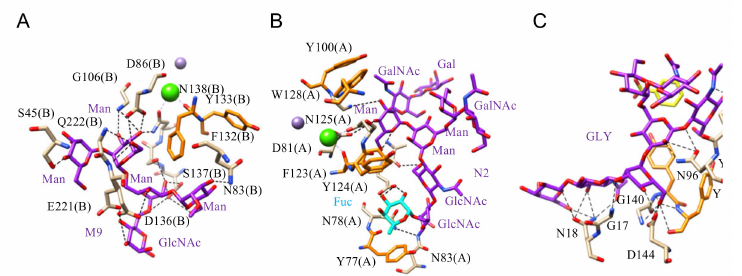
Figure 5. ( A ). Network of hydrogen bonds (black dashed lines) anchoring Man9 (M9) to PAL, the Pterocarpus angolensis lectin (PDB code 2PHN). Aromatic residues F132 and Y133 participating in stacking interactions with the pyranose rings of the oligomannoside are colored orange. ( B ). Network of hydrogen bonds (black dashed lines) anchoring N2 oligosaccharide to LoLII, isolectin II from Lathyrus ochrus (PDB code 1LGB). Aromatic residues Y77, Y100, F123, Y124, and W128 involved in stacking interactions with the pyranose rings of the oligosaccharide, are colored orange. The α 1,6-linked fucose (Fuc) participates in the H-bond network. ( C ). Network of hydrogen bonds (black dashed lines) anchoring a biantennary glycan (GLY) to Calsepa from Calystegia sepium (PDB code 5XFI). Aromatic residue Y141 and Y142 participating in stacking interaction with the pyranose rings of the glycan are colored